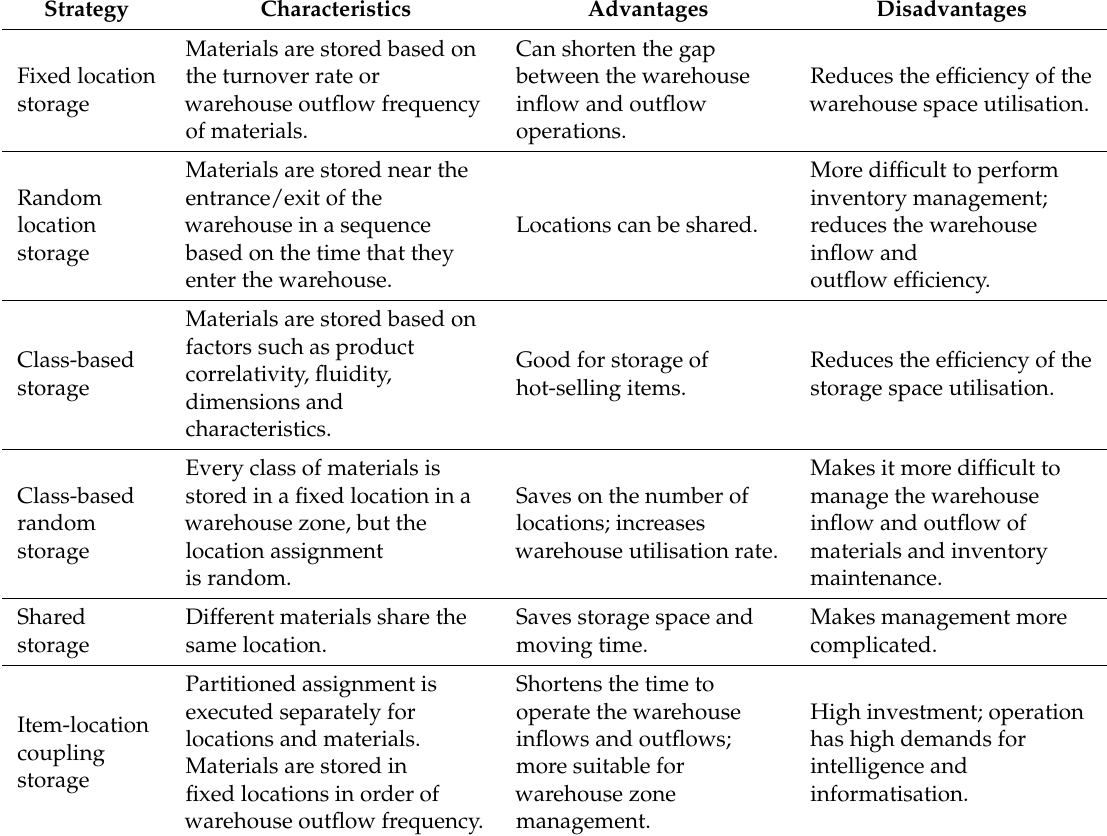
Table 1. The comparison of the different storage strategies